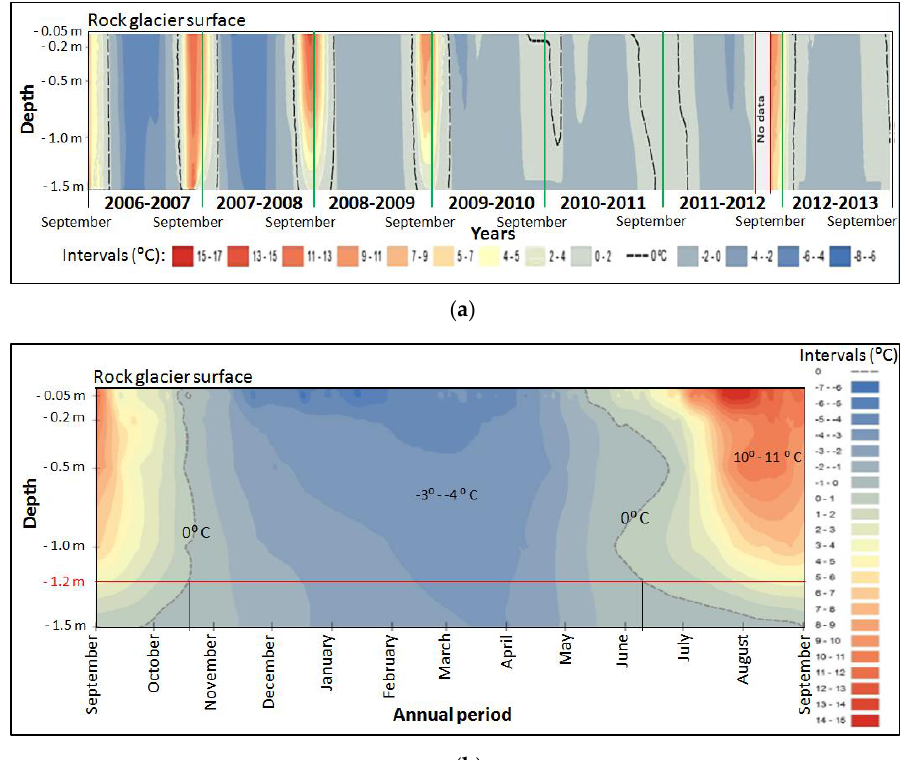
Figure 9. Representation of the thermal record from thermometers placed at −0.05 m (surface), −0.20 m, −0.50 m, −1.00 m and − 1.50 m from the surface. ( a ) The period of seven years from September − 0.20 m, − 0.50 m, − 1.00 m and − 1.50 m from the surface. ( a ) The period of seven years